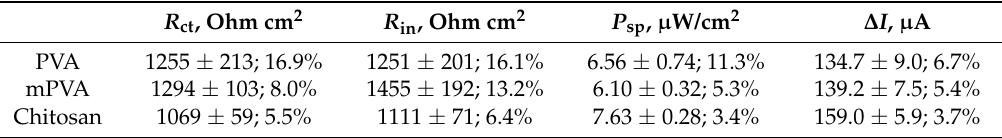
Table 1. Values of the bioelectrochemical characteristics of electrodes modified by various polymers. R ct , Ohm cm 2 R in , Ohm cm 2 P sp , μW/cm 2 ∆ I , μА PVA 1255 ± 213; 16.9% 1251 ± 201; 16.1% 6.56 ± 0.74; 11.3% 134.7 ± 9.0; 6.7% mPVA 1294 ± 103; 8.0% 1455 ± 192; 13.2% 6.10 ± 0.32; 5.3% 139.2 ± 7.5; 5.4% Chitosan 1069 ± 59; 5.5% 1111 ± 71; 6.4% 7.63 ± 0.28; 3.4% 159.0 ± 5.9; 3.7% Note: mean values of 10 measurements, standard deviations from the mean values and the measuring errors in per cent are given.